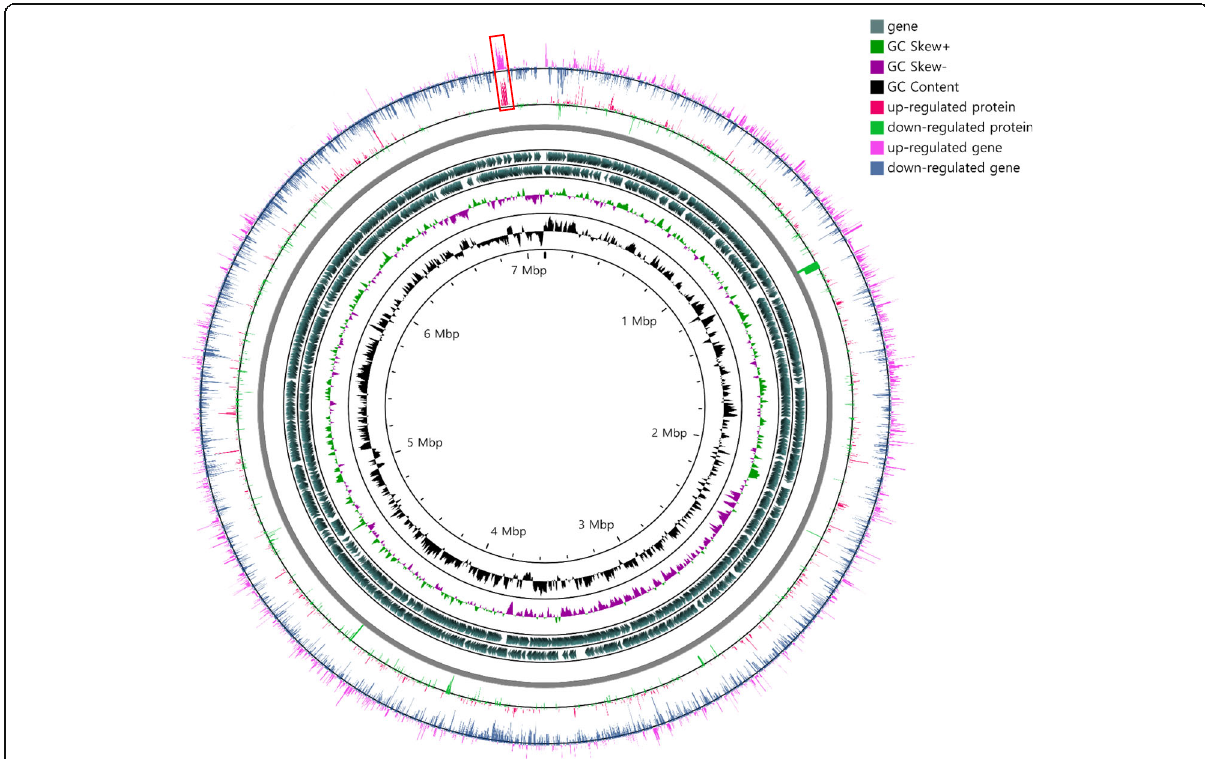
Fig. 1 Multi-layered omics information of Delftia sp. K82. The inner black circle indicates GC content, and the green and purple circles represent the GC skew of Delftia sp. K82 genome. The first and second outer rings show the log 2 fold change values for transcriptomics and proteomics when compared to aniline and LB conditions, respectively. The location of the aniline degradation cluster is indicated by a red